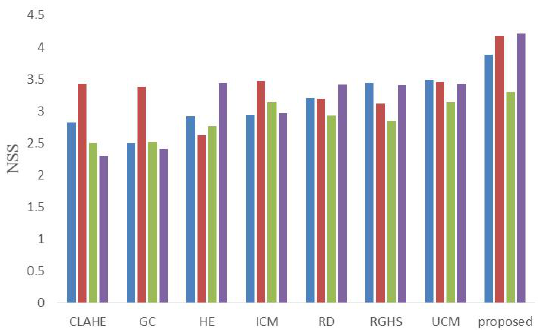
Figure 8. NSS of different methods in Fig.4 (a)Original (b)CLAHE (c)GC (d) HE (e)ICM (f)RD (g)RGHS (h)UCM